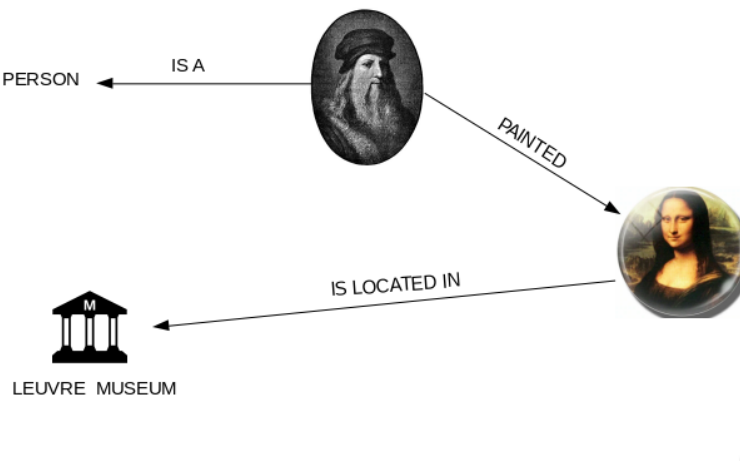
Figure 2. Extended graph with two entities and its